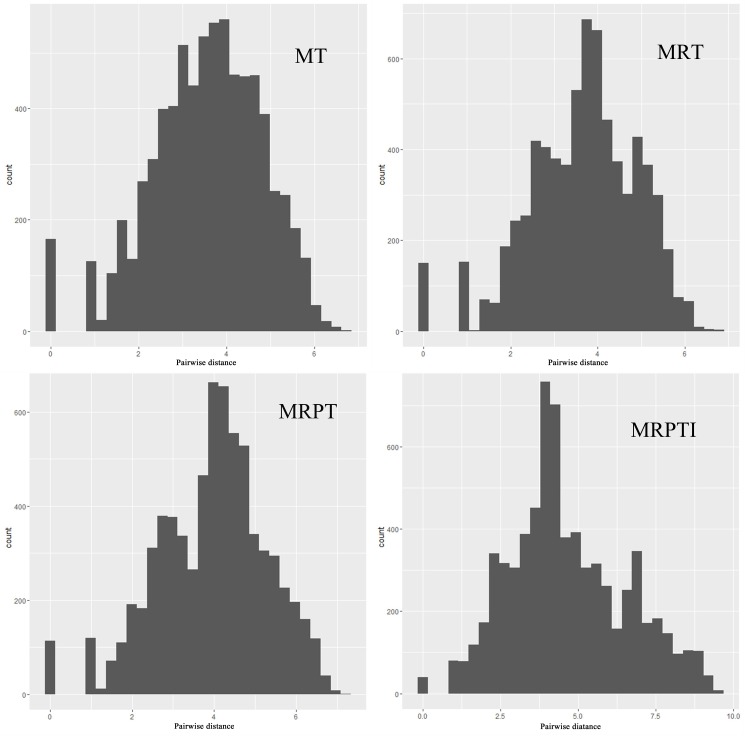
Genetic distance histograms for five combined regions (matK+trnL-H, MT; matK+rbcL+trnL-H, MRT; matK+rbcL+psbA-trnH+trnL-H, MRPT; matK+rbcL+ITS+trnL-H, MRIT; matK+rbcL+psbA-trnH+trnL-H+ITS, MRPTI).The dataset from this study was obtained with MEGA 6.0 Compute Pairwise Distance, and the histograms were generated using R 3.2.3.